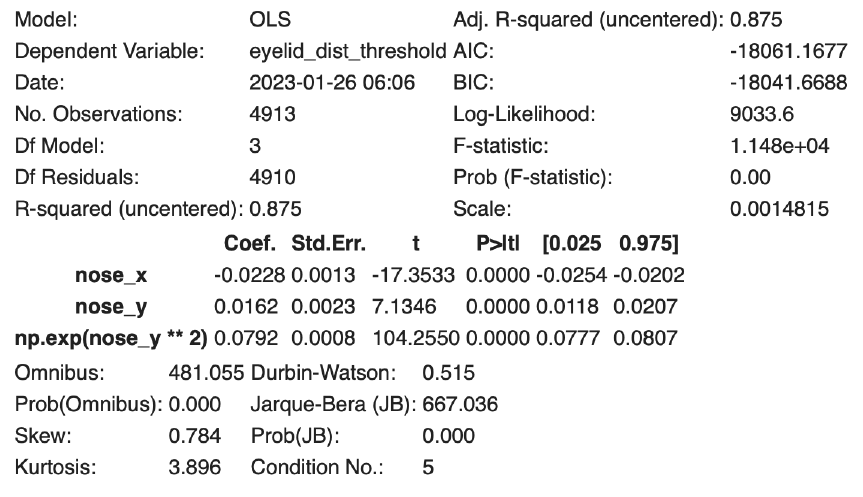
Figure 4. OLS regression on eyelid distance w.r.t. face orientation (Equation (9)).